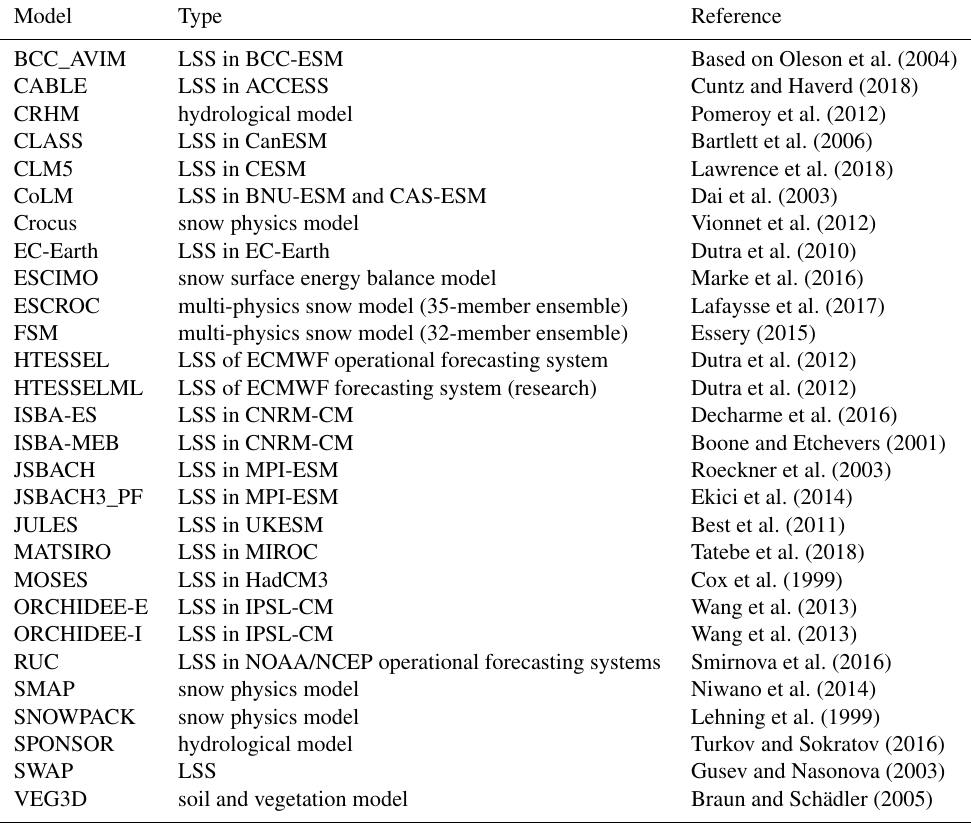
Table 1. Models performing ESM-SnowMIP reference site simulations.